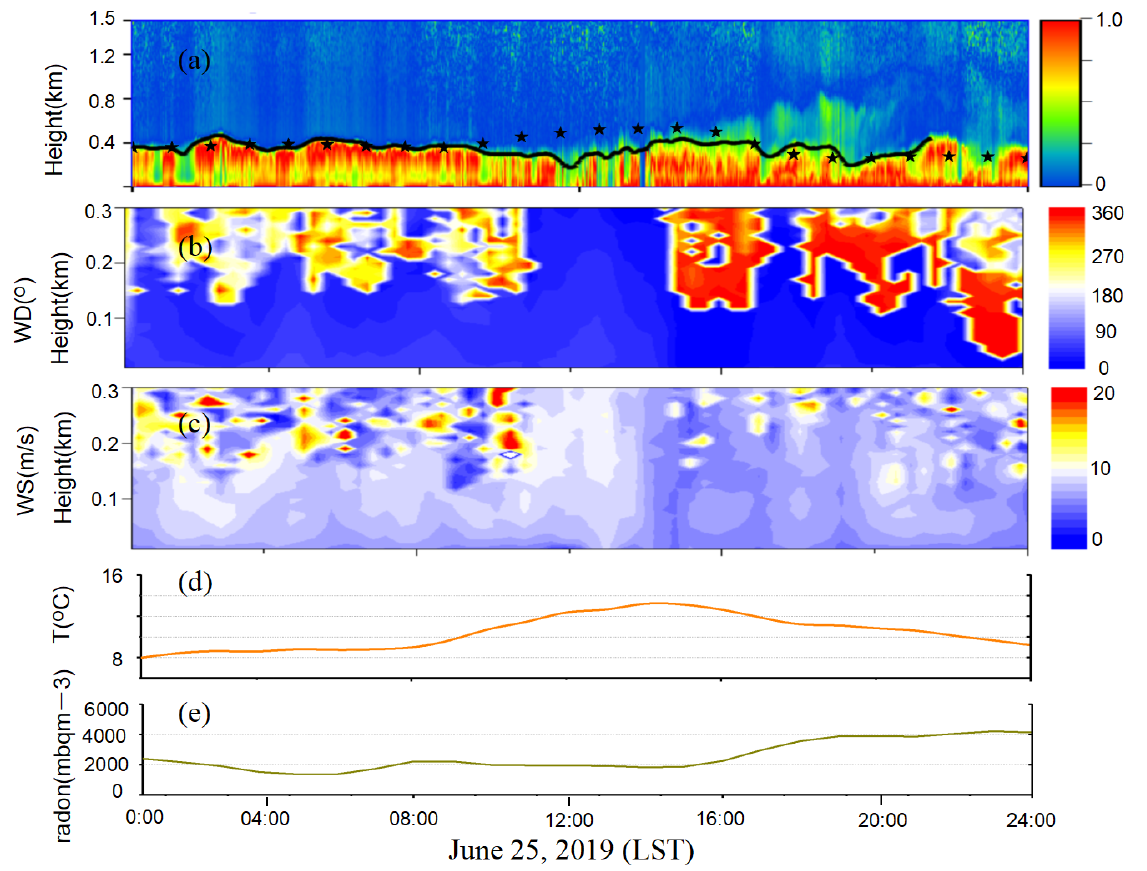
Figure 8. Another example illustrating the retrieval of BLH using the ceilometer measurements obtained on 25 June 2019 over Cape Grim. ( a ) Time-height cross section of the range-squared corrected ceilometer signal intensity during the entire diurnal cycle. Black lines and black stars indicate the BLH estimations from the IED based on ceilometer and ERA5 reanalysis, respectively. Vertically aligned color bar (in linear scale) on the right indicates the intensity in arbitrary units. ( b ) Wind direction form sodar, ( c ) wind speed from sodar, ( d ) near-surface temperature, and ( e ) radon